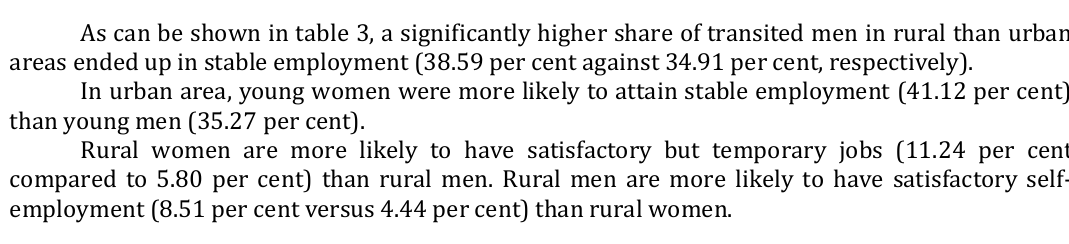
Table 3: Transited youth by category, gender and area of residence (%) Sub-category Gender